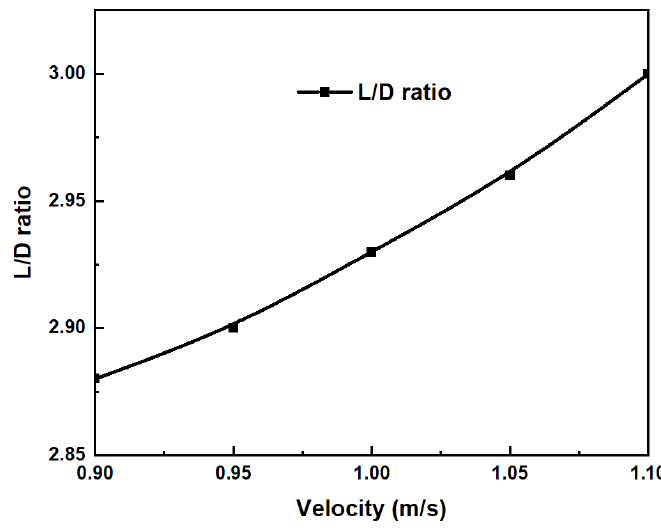
Fluids 2021 , 6 , x FOR PEER REVIEW Figure 9. Lift to drag ratio with the angle of attack θ = −10 ° at the different velocities. Figure 9. Lift to drag ratio with the angle of attack θ = − 10 ◦ at the different velocities.